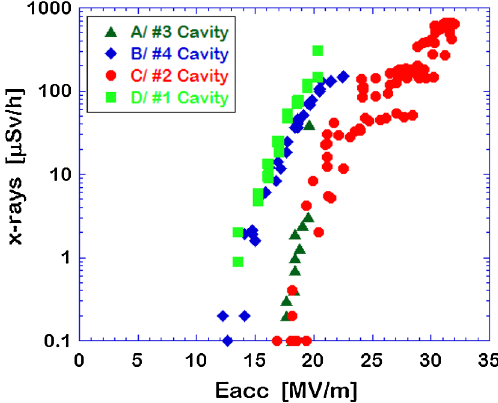
FIG. 20. (Color) Relation between x-ray radiation levels and accelerating gradients in four cavities in pulsed operation with 1.5 ms and 5 Hz.